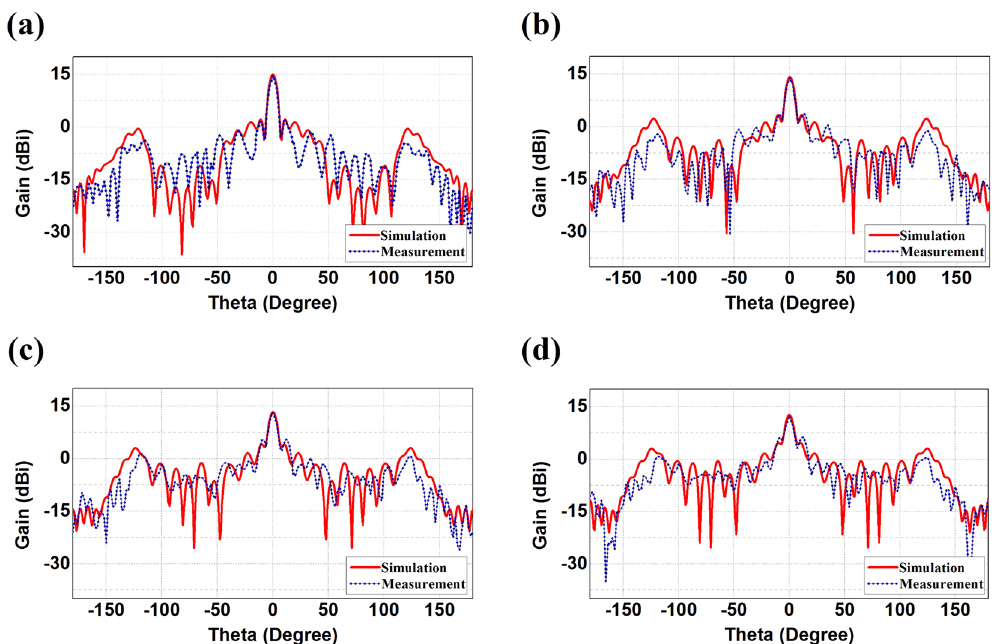
Figure 8. Comparisons of the measured radiation patterns and the simulation results of the convex meta- mirror. ( a ) 15 GHz, ( b ) 15.3 GHz, ( c ) 15.5 GHz, and ( d ) 15.7